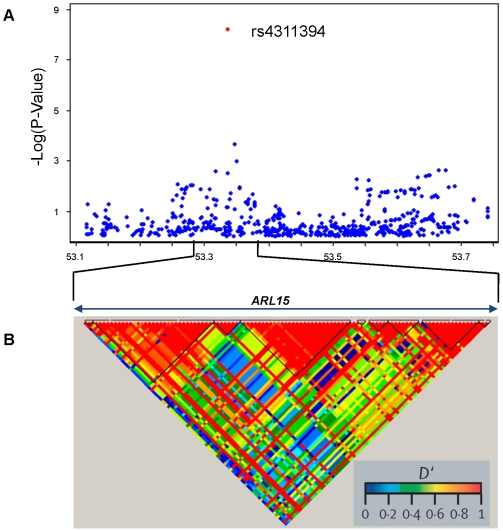
Association between SNPs near ARL15 and adiponectin levels.(A) −Log(P-value) measures for association between single nucleotide polymorphisms (SNPs) and chromosomal position. (B) Linkage disequilibrium in GOLD heat map Haploview 4.0 color scheme, CEPH (Centre d'Étude du Polymorphisme Humain) population. The x axis represents genomic position in Mb (A) and in kb (B). All P-values are derived from the discovery meta-analysis of CoLaus, TwinsUK, and Genetic Etiology of Metabolic Syndrome (GEMS) cohorts, except that for the lead SNP, rs4311394 (in red), which is derived from the combined P-value from the CoLaus, TwinsUK, GEMS, Framingham, InCHIANTI, Baltimore Longitudinal Study of Aging (BLSA), Avon Longitudinal Study of Parents and Children (ALSPAC), and European Prospective Investigation of Cancer-Norfolk (EPIC-Norfolk) cohorts.